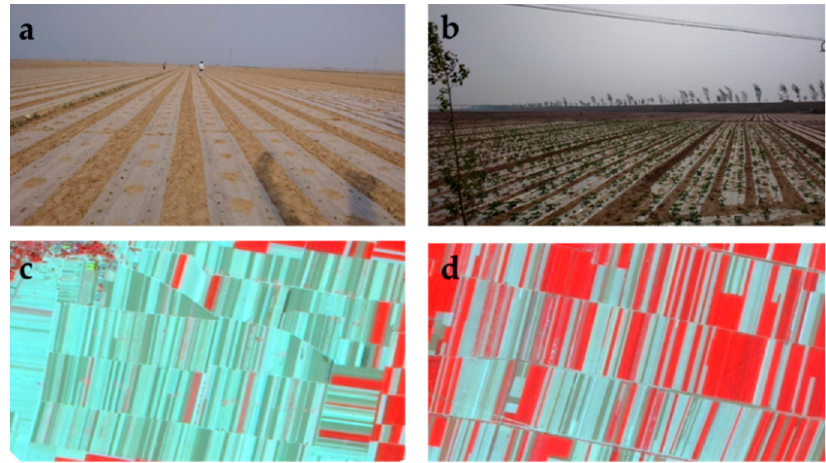
Figure 9. The PMF in Jizhou ( a ) Field photo of PMF at the sowing stage; ( b ) Field photo of PMF at the seedling stage; ( c ) PMF separated by bare soil in false colour composite (R: NIR, G: Red, B: Green) GF-1 imagery; ( d ) PMF separated by well-developed crops in false colour composite (R: NIR, G: Red, B: Green) GF-1 imagery.